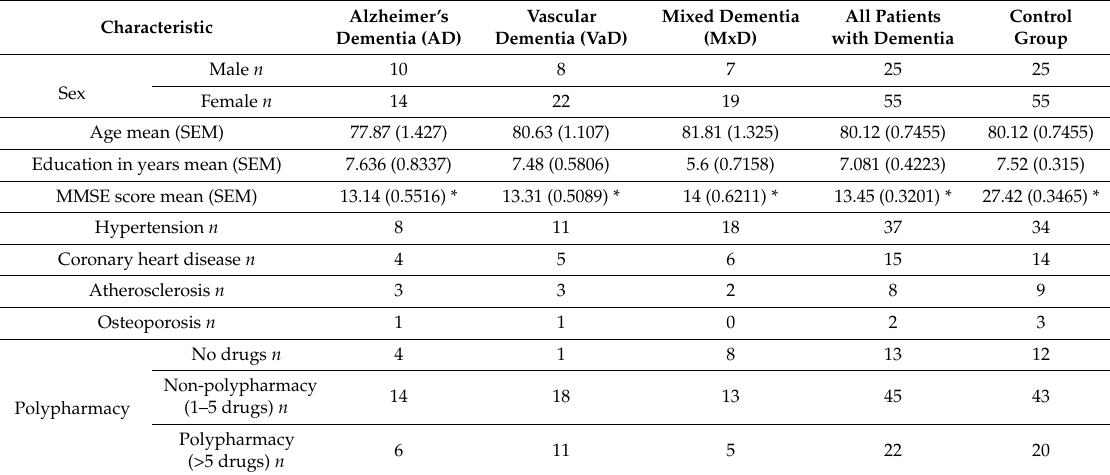
Table 1. Demographic data and general health of the patients.